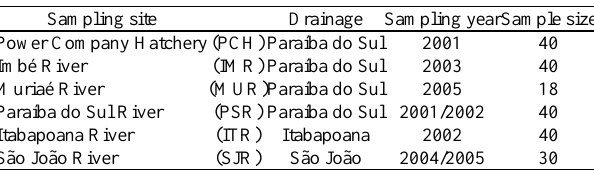
Table 1. Sampling sites and respective drainages, sampling years and number of samples.